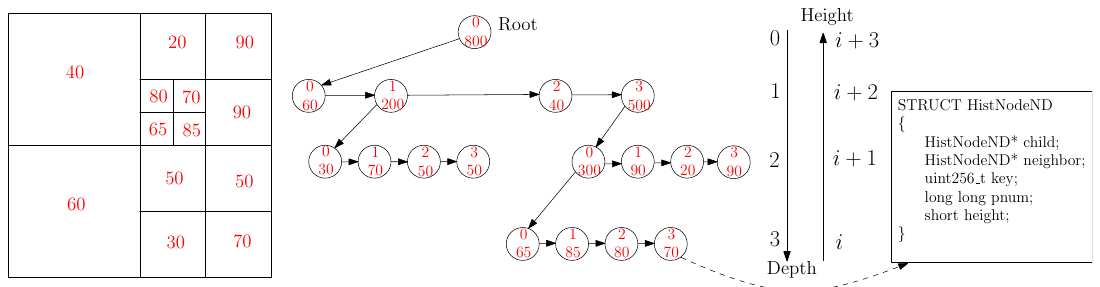
Figure 3. The loading and querying procedure of HistSFC